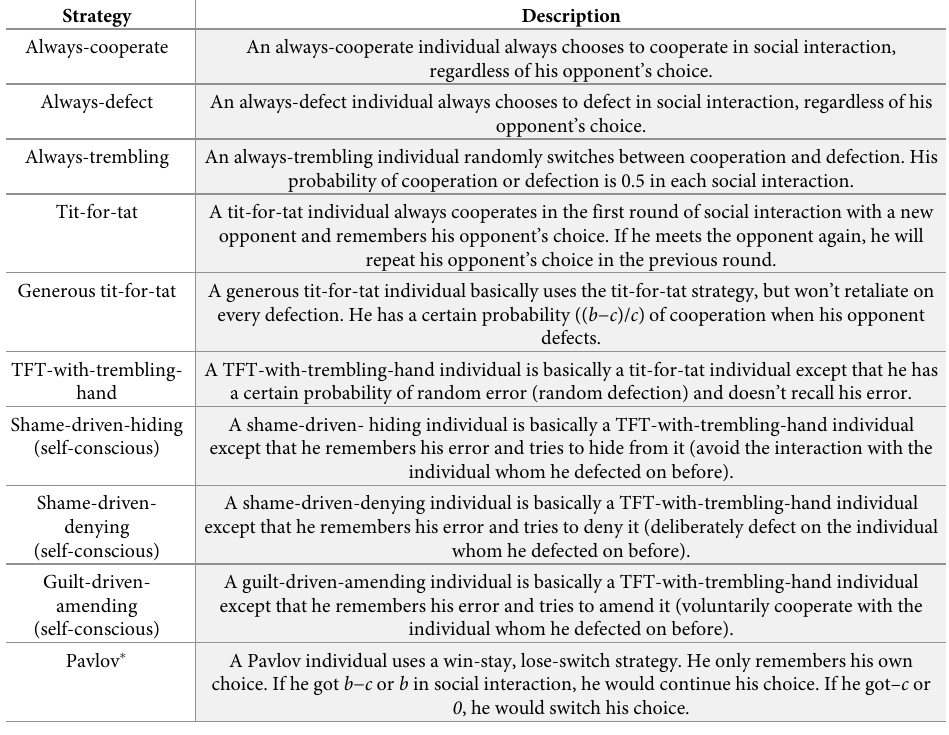
Table 1. Ten strategies tested in the